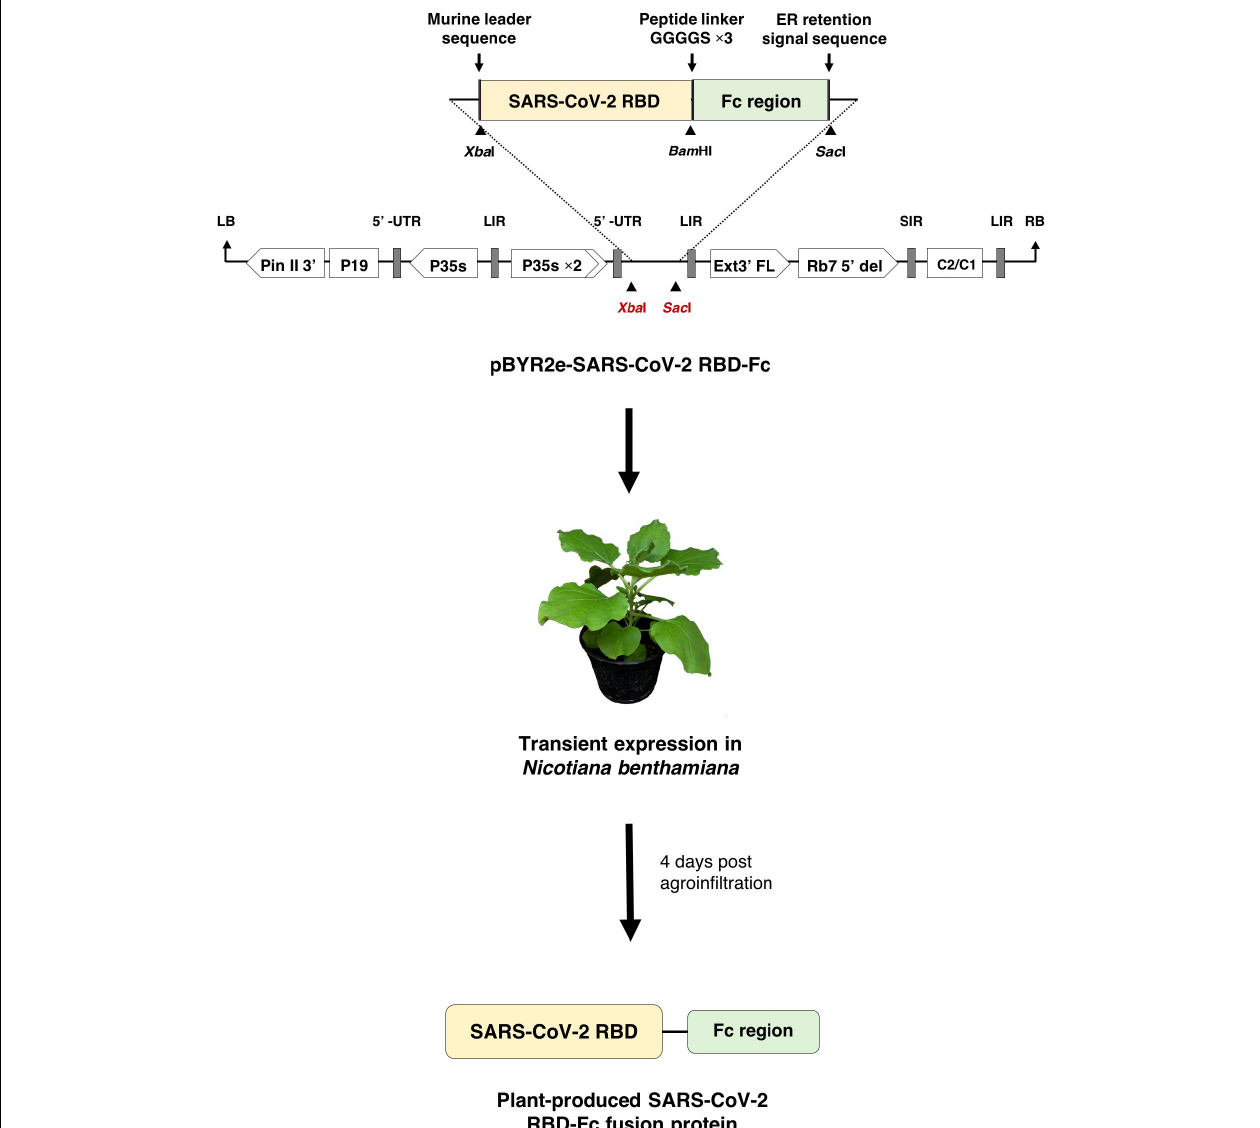
FIGURE 1 | Diagrammatic representation showing the T-DNA of plant expression vector pBYR2e-SARS-CoV-2 RBD-Fc and the overview of transient expression in N. benthamiana plants. RB and LB, left and right borders of the T-DNA used in Agrobacterium DNA delivery into plant cells; Pin II 3’, the terminator from potato proteinase inhibitor II gene; P19, the RNA silencing suppressor from Tomato Bushy Stunt Virus (TBSV); P35s, 35s promoter from Cauliflower Mosaic Virus (CaMV); P35s × 2, 35s promoter from CaMV with duplicated enhancer; Ext3’ FL, 3’ region of tobacco extension gene; Rb7 5’ del, tobacco RB7 promoter; SIR, short intergenic region of Bean Yellow Dwarf Virus (BeYDV); LIR, long intergenic region of BeYDV; C2/C1, Rep/RepA gene from BeYDV encoding for replication initiation protein (Rep) and RepA.